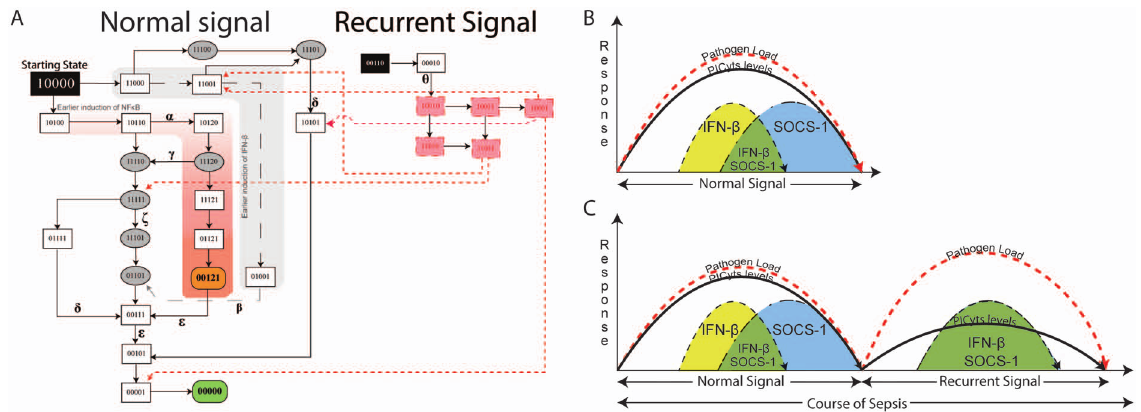
Figure 9. Implication of the study. (A) Edges labelled with Greek small letters and states as nodes are used to represent trajectories associated with different signalling events observed in this study (see legend in Figure 3). Specific states and trajectories of normal and recurrent signalling shown in Figures 3–8 were used to draw the hypothesis shown in (B–C). Possible effects of TLR4 and JAK/STAT signalling on pathogen load, induction pattern of PICyts, IFN- b and SOCS-1 mediated downregulation of PICyts are shown for non-septic (B) and septic (C) cases. During non-septic case, the pattern of IFN- b and then SOCS-1 limits the qualitative levels of PICyts along with the successful reduction of pathogen load. On the other hand, during sepsis, it has been proposed that changed expression pattern of IFN- b and SOCS-1 inhibit the PICyts with resultant increase in the pathogen load.